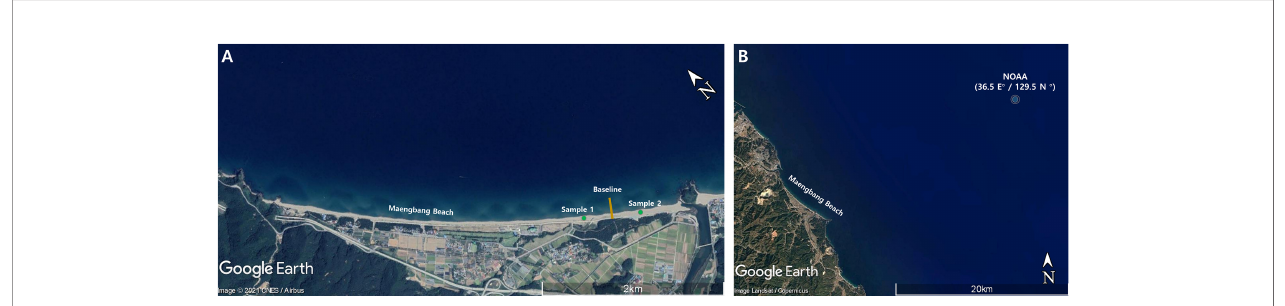
FIGURE 7 | Location of Maengbang Beach: (A) sand and shoreline data (B) NOAA data (Google Earth Image).